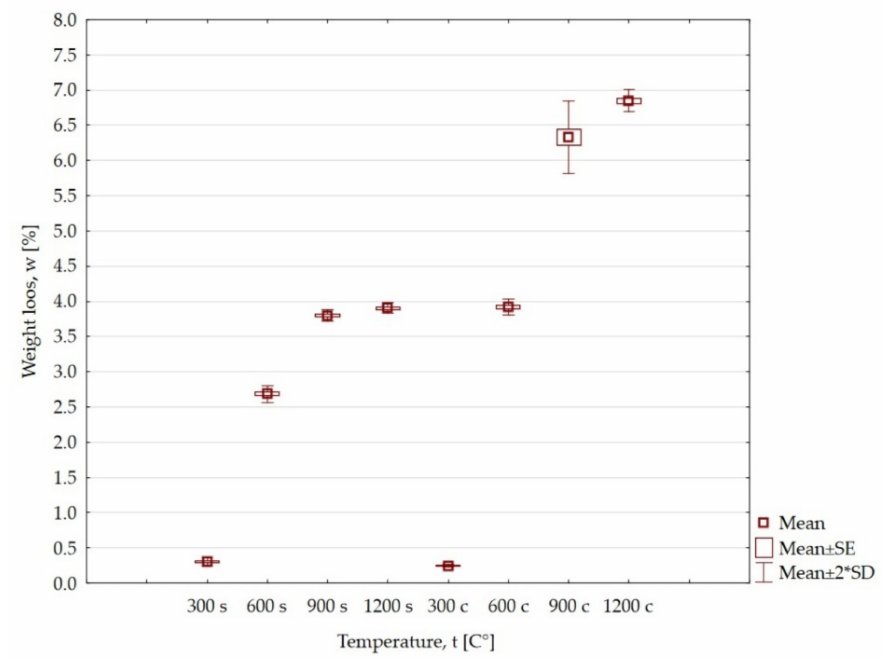
Figure 9. The influence of high temperatures on the weight loss for sandstone and claystone samples: s—sandstone; c—claystone; SE—standard error; SD—standard deviation.